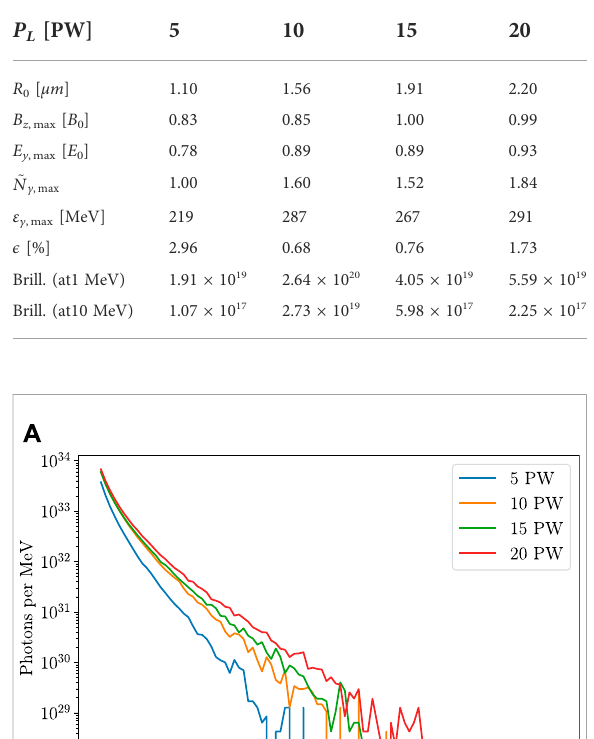
TABLE 2 Table for quantities as in Table 1 but for the laser pulse duration τ =40 fs. The normalized laser pulse amplitude remains the same a 0 =350 as in Table 1.